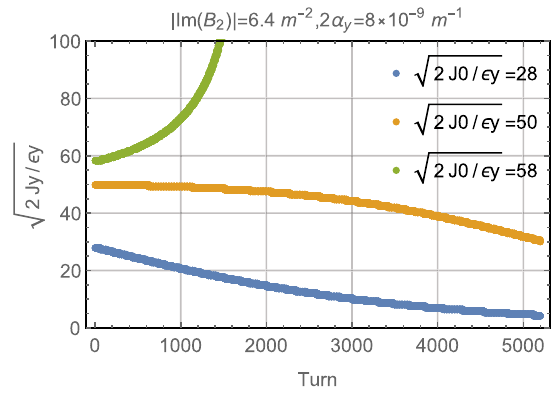
FIG. 12. Evolution of normalized square root of vertical action from tracking corresponding to initial conditions y ¼ 50 σ y ¼ 57 . 5 σ , y ¼ 58 σ , and adjusted longitudinal initial condi- y y tions (30) and (31).